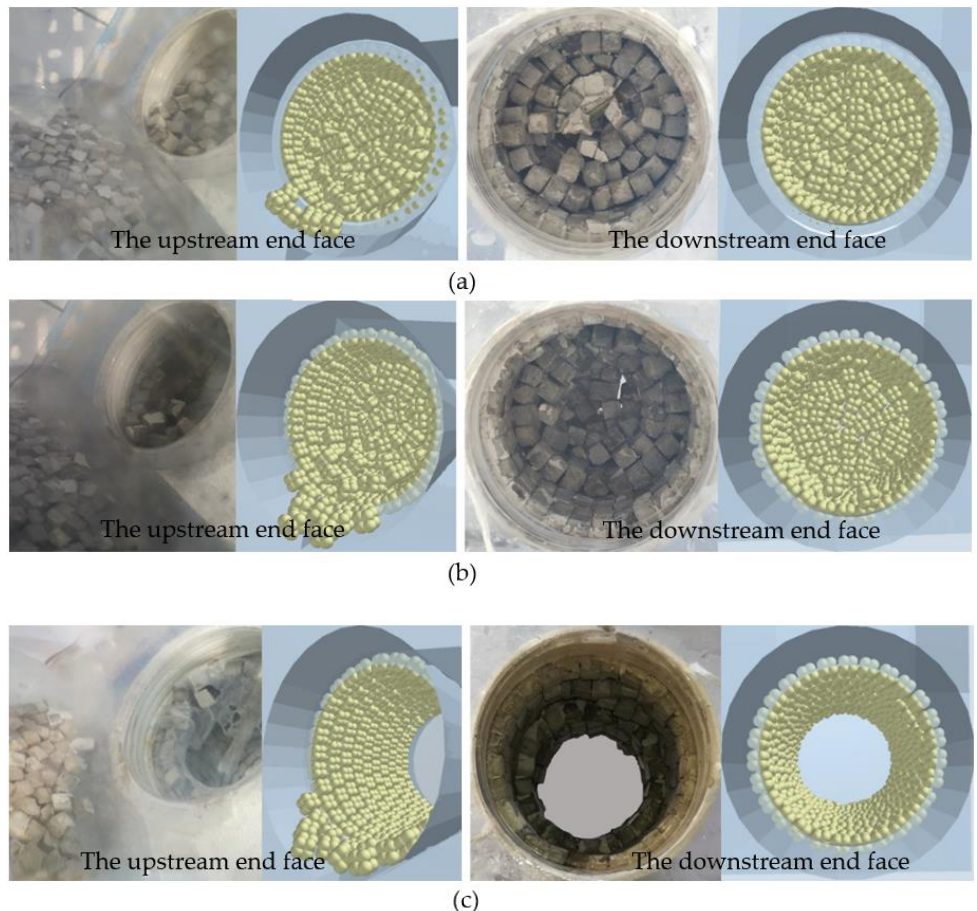
Figure 16. Comparison between simulation results and experimental results: ( a ) β = 30°, h = 105 mm; ( b ) β = 30°, h = 205 mm; ( c ) β = 30°, h = 305 mm.